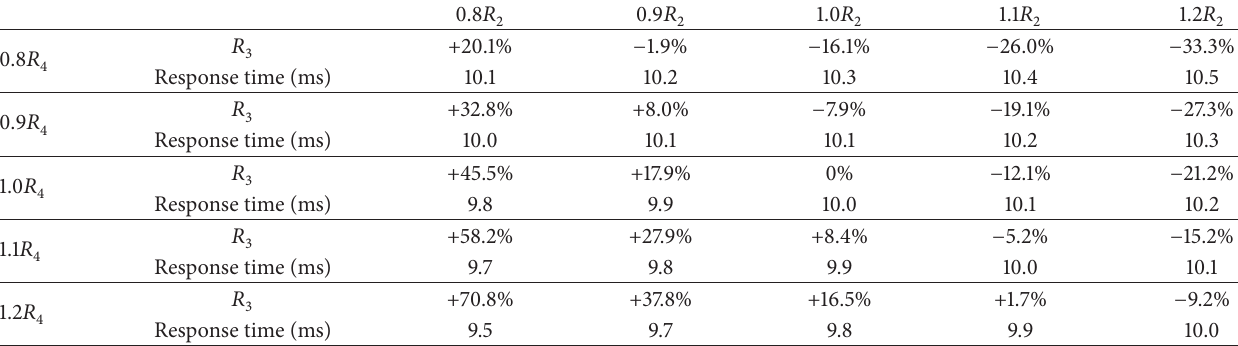
Table 6: Changing rate of 𝑅 3 and response time due to changes in 𝑅 2 and 𝑅 4 .